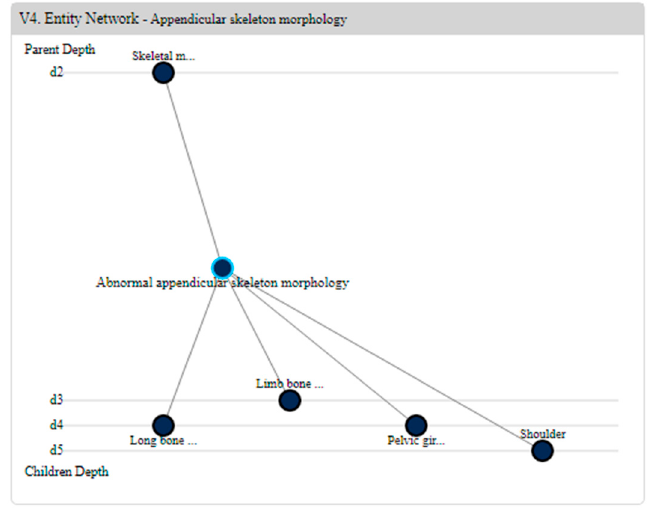
Figure 30. The initial state of the Entity Network Panel subview when an ontology entity is chosen as the initial position. In this case, “Abnormal Appendicular Skeleton Morphology” has been selected. We see that the chosen “Abnormal Appendicular Skeleton Morphology” entity directly inherits from a single ontology entity and is inherited from four other ontology entities on various ontology section levels. We then select two entities for the entity network within the prior Level Landmark Entities Panel subview, and the two ontology entities are used as positions side-by-side, as depicted in Figure 31.